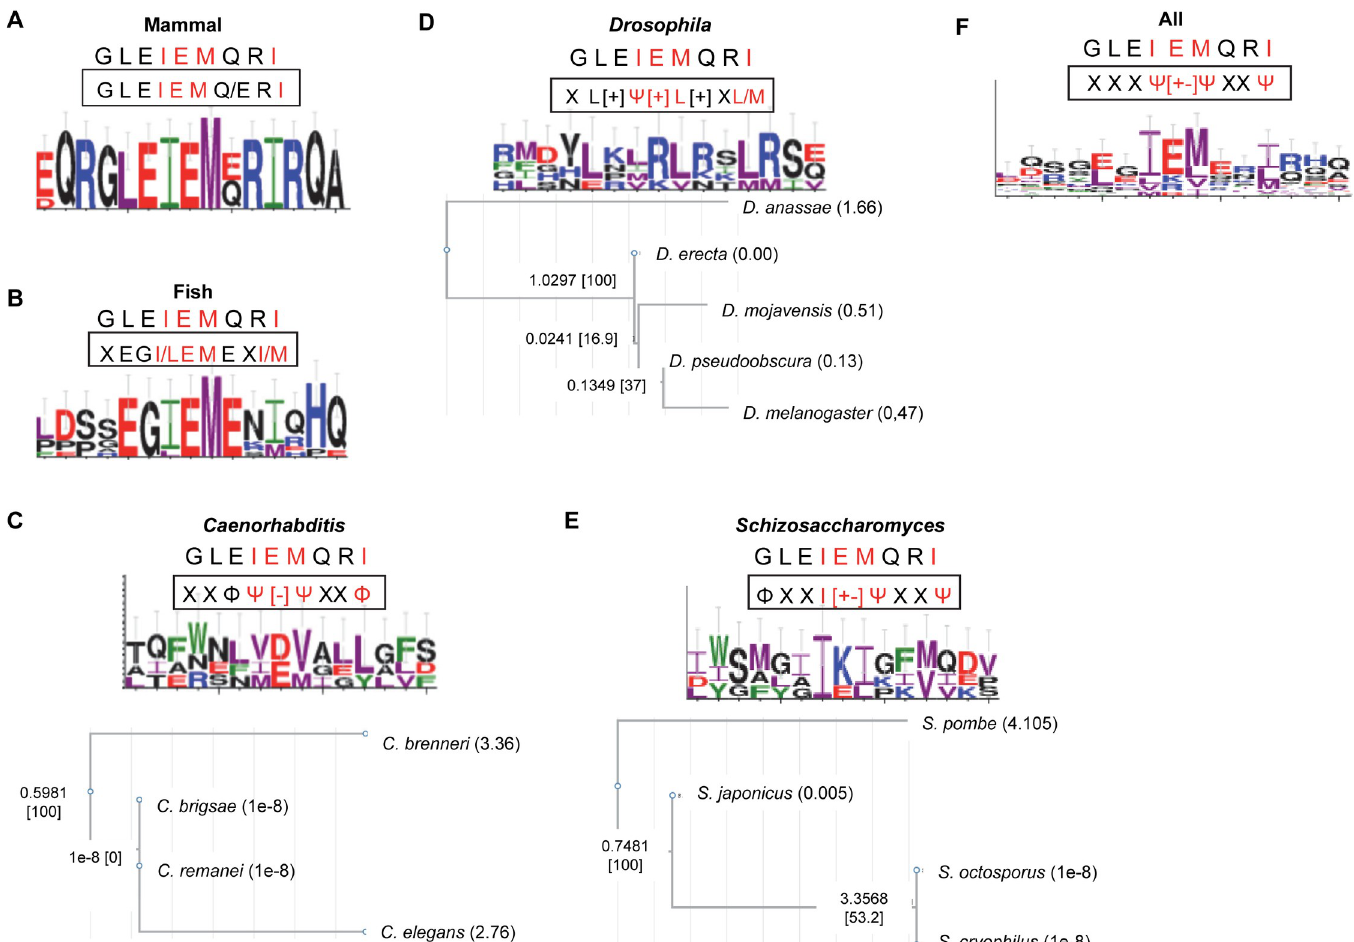
Fig 9. Conservation of the retromer sorting motif in PC2 sequences from different organisms. The panels show Weblogos that indicate the conservation of the residues in equivalent positions of the N-terminal regions of polycystin-2 (PC2) sequences retrieved from Uniprot and NCBI databases (see the S5 File for details). The PC2 sequences from Mammal (A), Fish (B), Caenorhabditis (C), Drosophila (D), Schizosaccharomyces (E), and from all the organisms under study (F) were compared using ClustalW before the analysis. In each panel, the human PC2 sequence that includes the sorting motif is shown at the top, and the group consensus is shown into a rectangle. E, D in red; H, K, and R in blue; F, Y, and W in green; and I, L, M, and V in purple. The phylogeny of Drosophila , Caenorhabditis and Schizosaccharomyces sequences is shown in the lower C, D, and E panels,